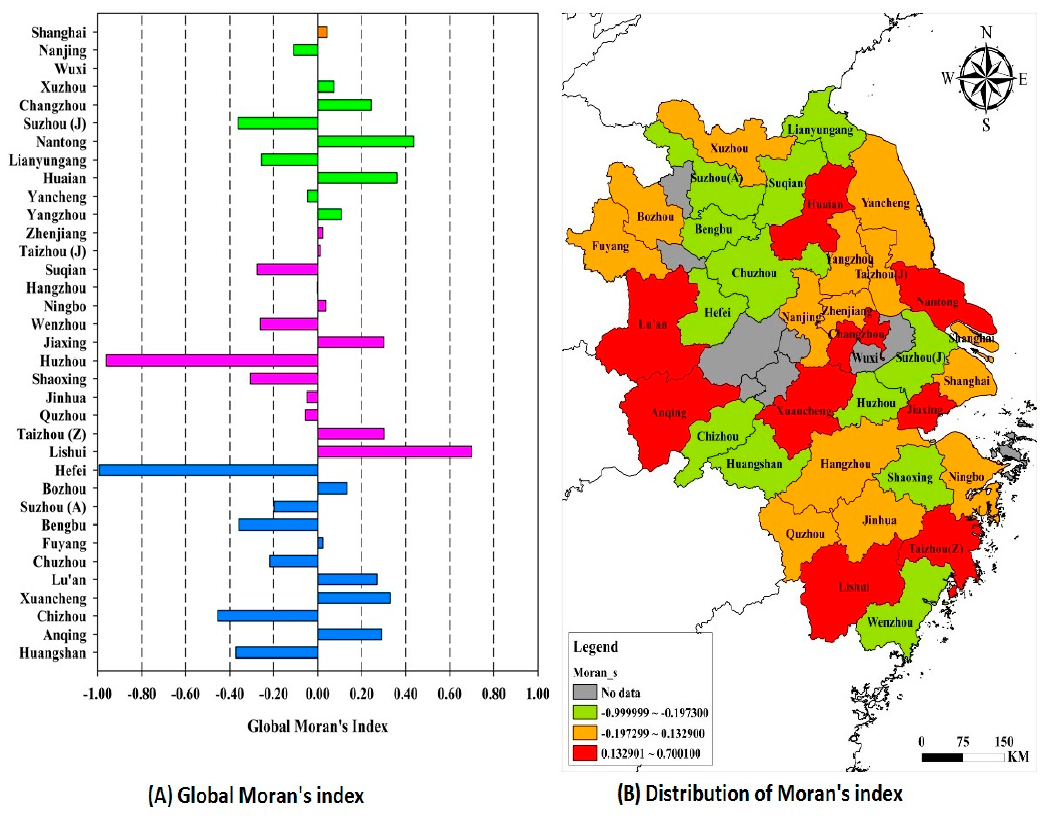
Figure 5. Global Moran’s index of cities ( A ) and its distribution ( B ).